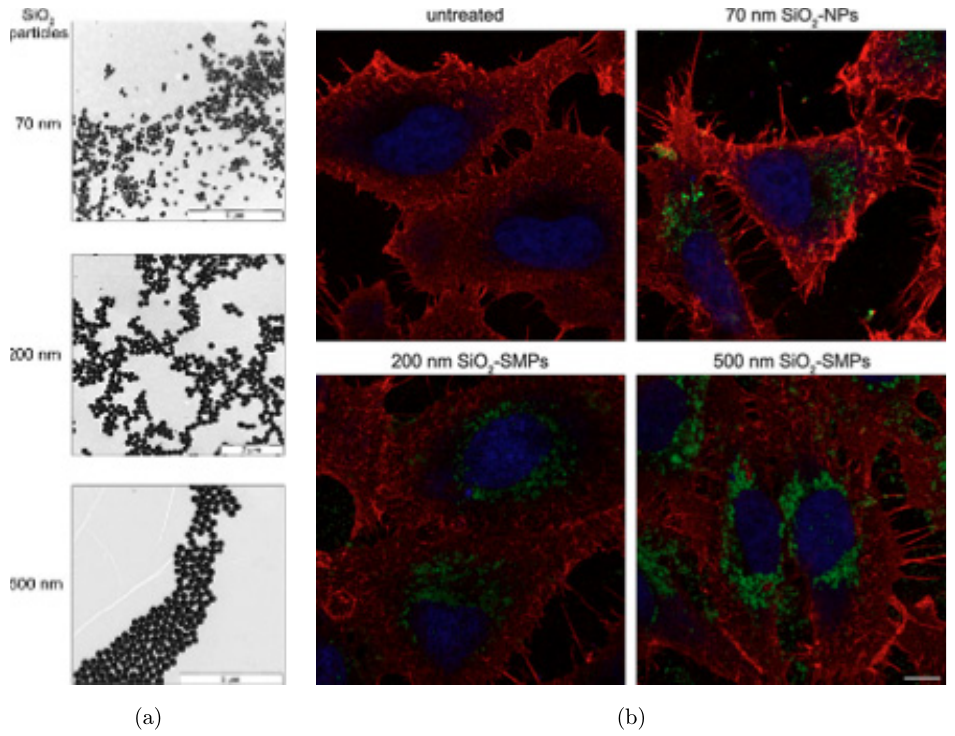
Fig. 3. (a) Size and morphology of the FITC-SNP. (b) Localization of the FITC-SNP (green) in HeLa cells assessed by HRCLSM. HeLa cells were exposed to 70 nm, 200 nm and 500 nm SNP or left untreated for 24 h. Blue refers to nuclear marker, red to membrane marker and green to FITC-SNP. Reprinted with permission from Ref. 57. Copyright ° c 2011